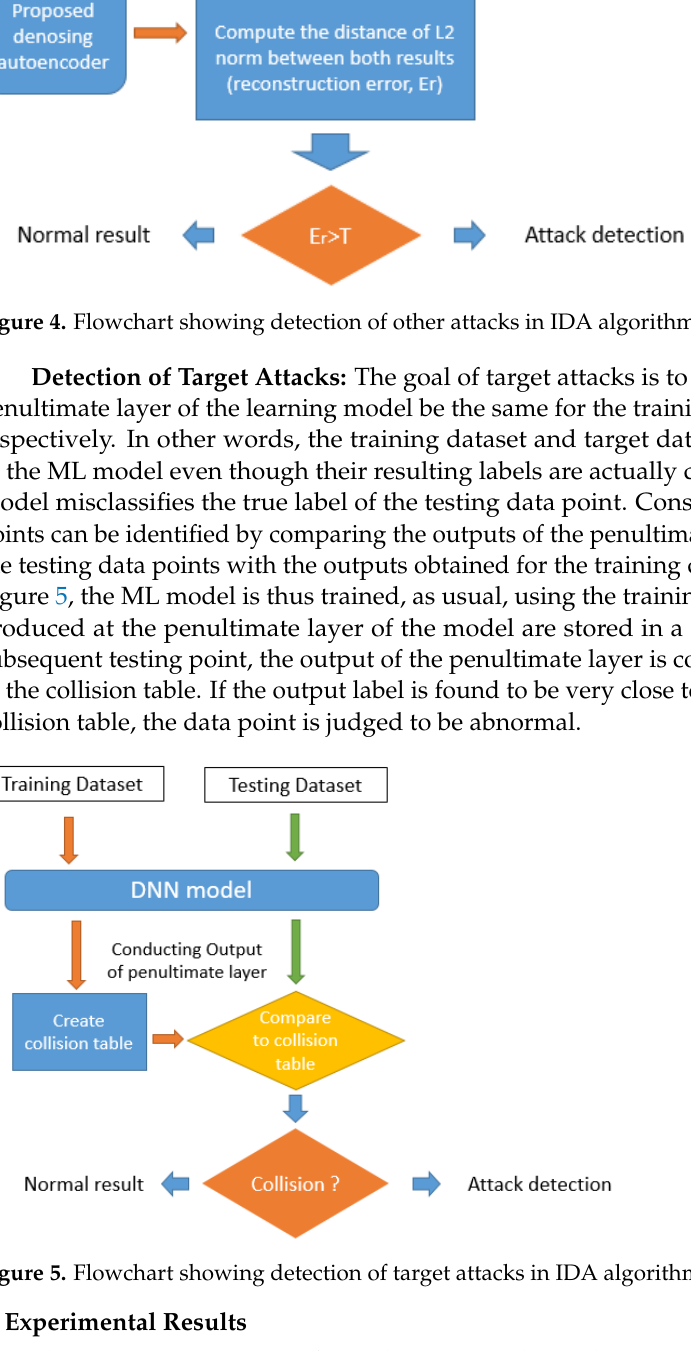
Figure 4. Flowchart showing detection of other attacks in IDA algorithm.